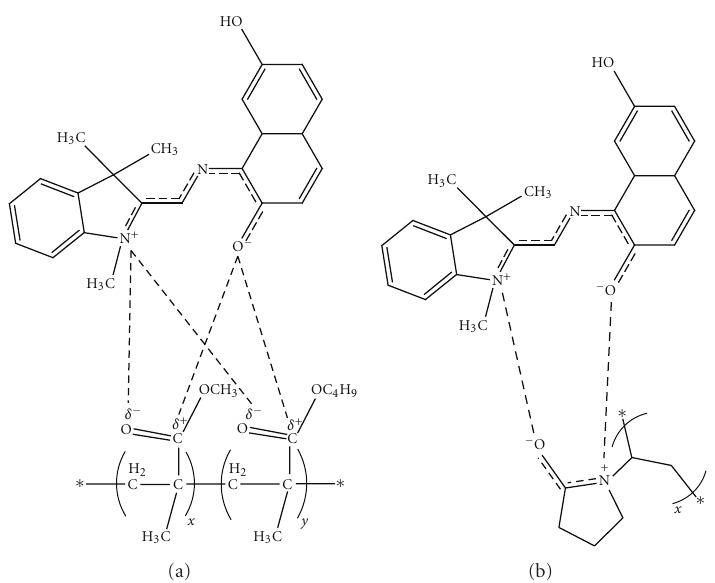
Figure 5: The dipole-dipole interaction between merocyanine and side chains of polymers (a) P(MMA - BMA) and (b)